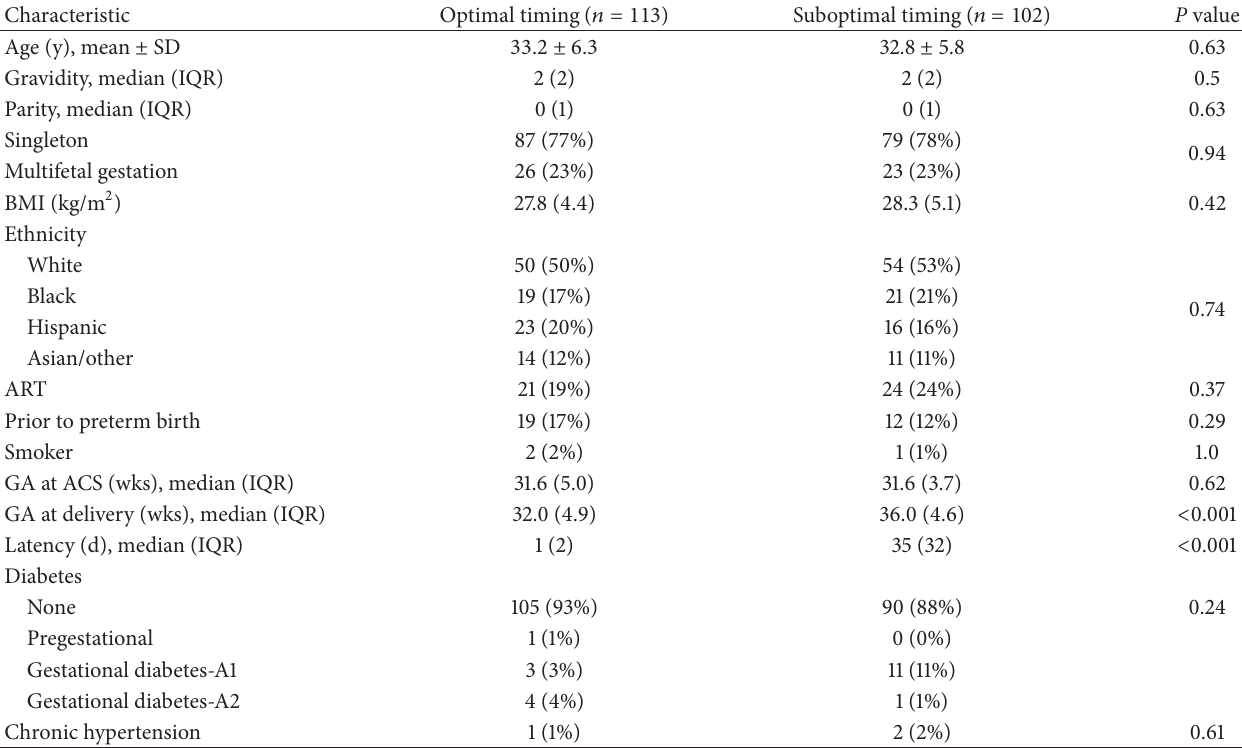
Table 1: Comparison of baseline maternal characteristics for mothers in the optimal timing and suboptimal timing groups.